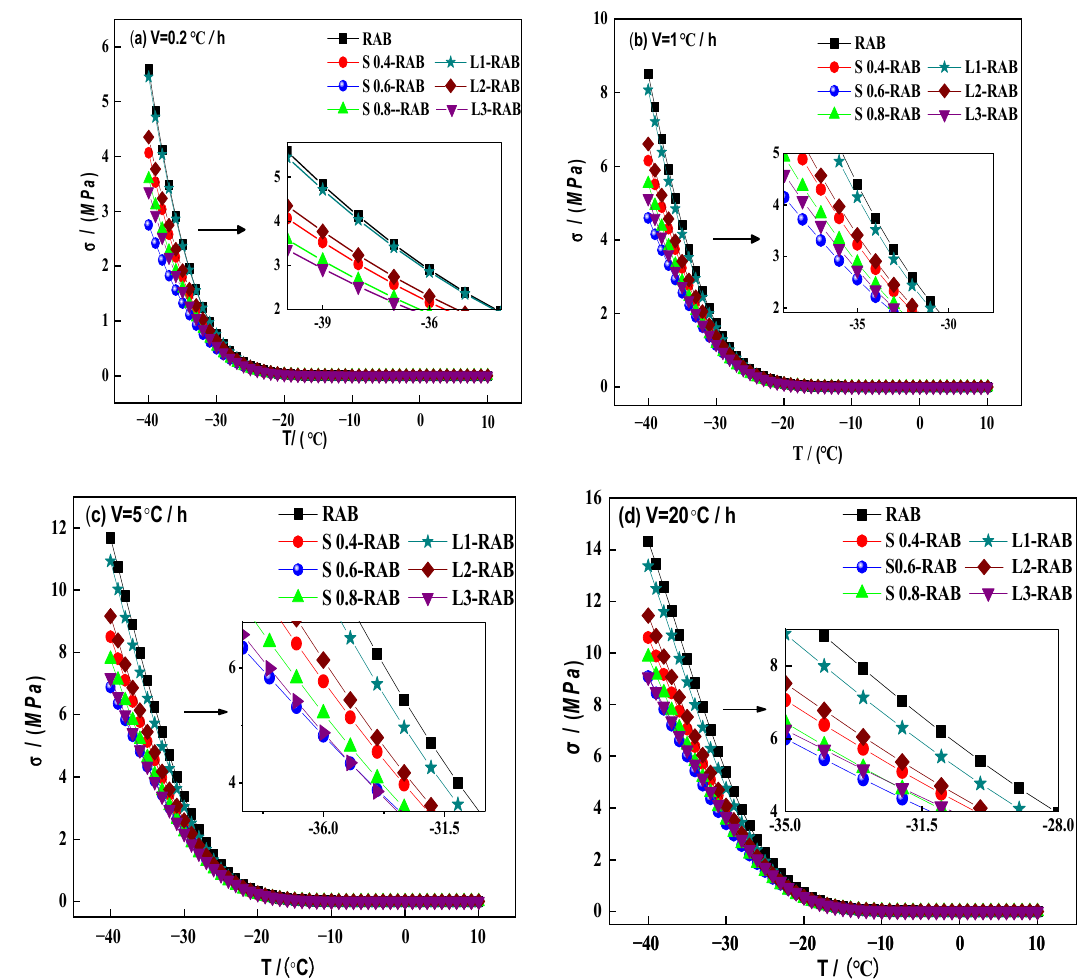
Figure 9. 𝜎(𝑇) for W-RABs ( a ) V = 0.2 ℃/h ; ( b ) V = 1 ℃/h ; ( c ) V = 5 ℃/h ; and ( d ) V = 20 ℃/h . Figure 9. σ ( T ) for W-RABs ( a ) V = 0.2 ◦ C/h; ( b ) V = 1 ◦ C/h; ( c ) V = 5 ◦ C/h; and ( d ) V = 20 ◦ C/h.